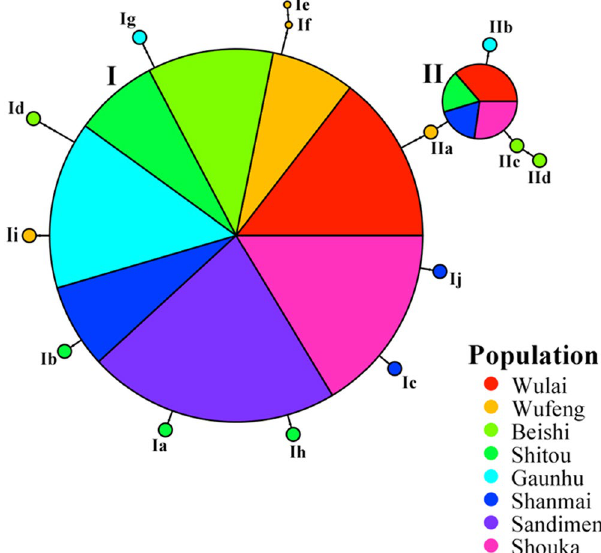
Figure 2. Haplotype network for Musa basjoo var. formosana based on nuclear superoxide dismutase gene intron 2 sequence data. The size of a circle corresponds to the haplotype frequency. Each line between haplotypes represents a mutational step; the dot represents another mutational step between haplotypes.